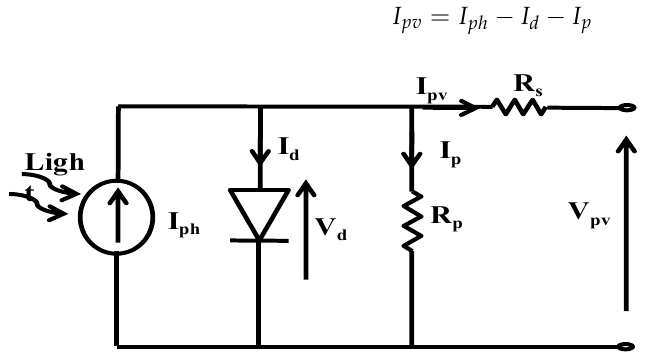
Figure 3. Electric circuit model of PV